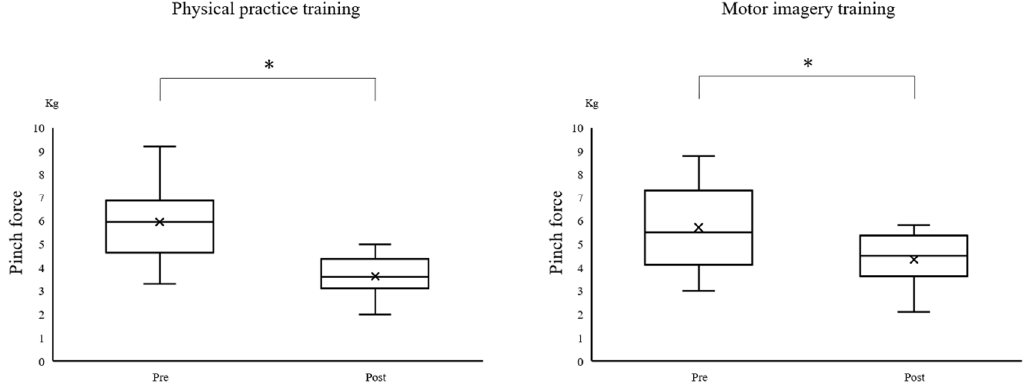
Figure 6. Comparison of the pinch force values before and after the intervention in each group. * Significant difference between pre- and post-terms, p < 0.05.